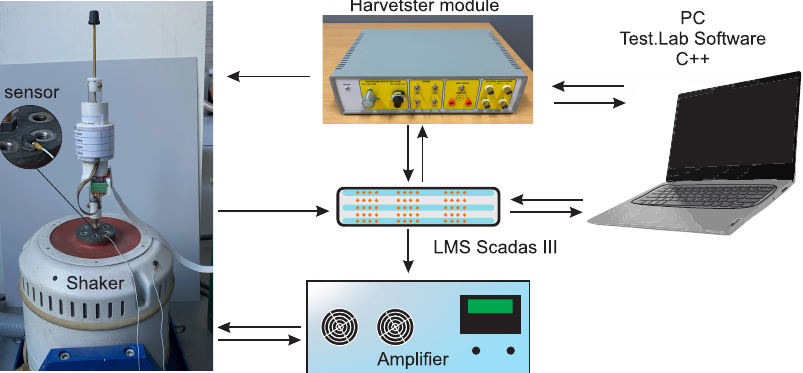
Figure 2. Scheme of the experimental setup with the prototype harvester.